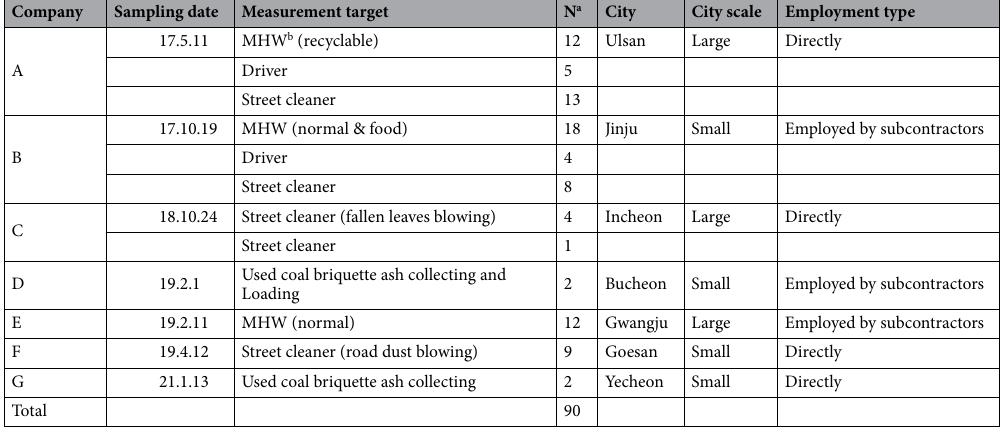
Table 1. Summary of study companies, job task, and number of respirable crystalline silica